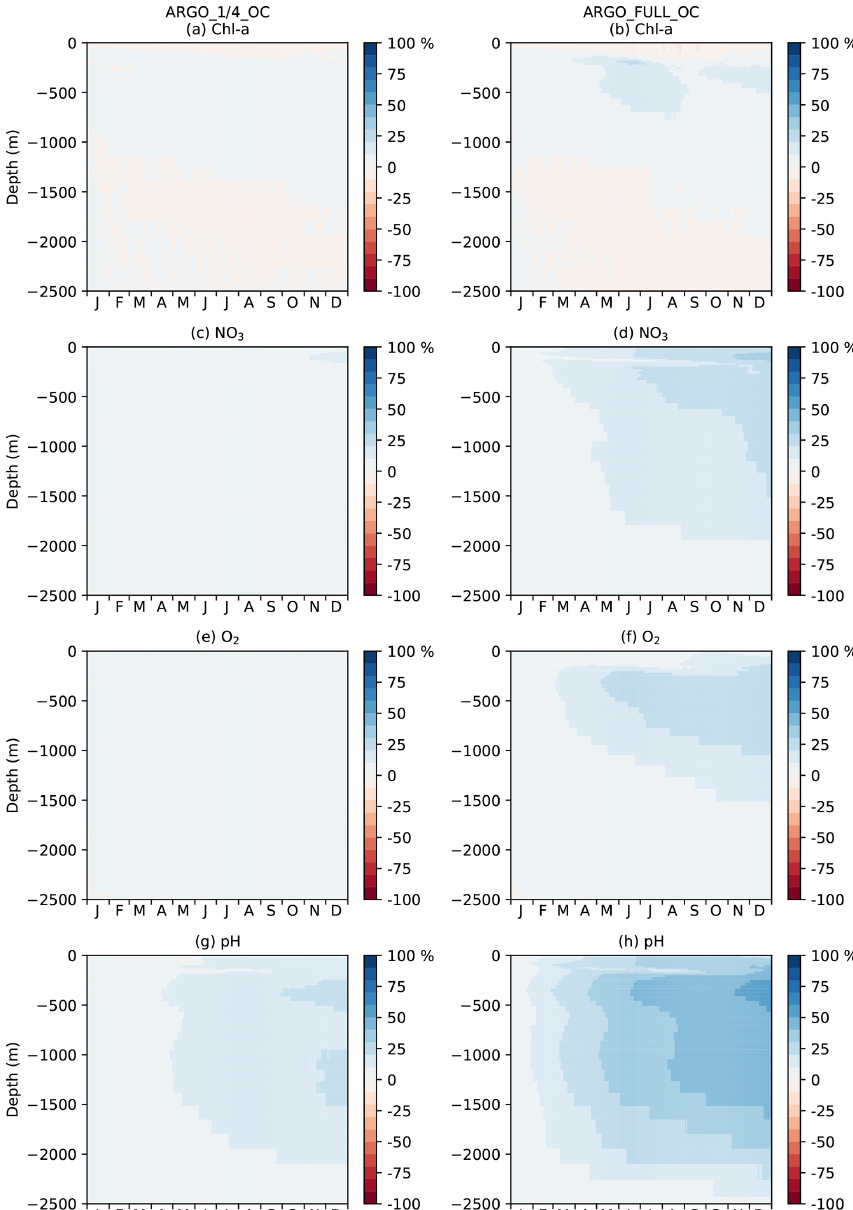
Figure 13. Hovmöller diagram of daily MAE red over OC with depth in the Southern Ocean for Chl a , NO 3 , O 2 , and